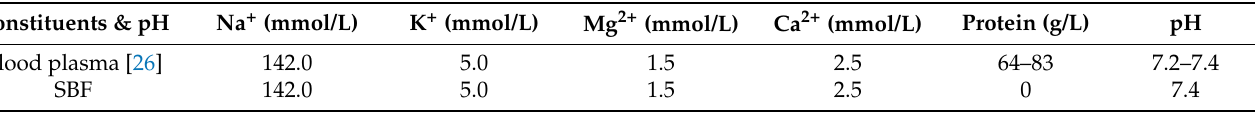
Figure 2. SEM image of fracture surface of ( a ) SN0, ( b ) SN5, ( c ) SN10, ( d ) SN20 and ( e ) SN30. Table 1. Ion concentration of simulated body fluid (SBF) and plasma.